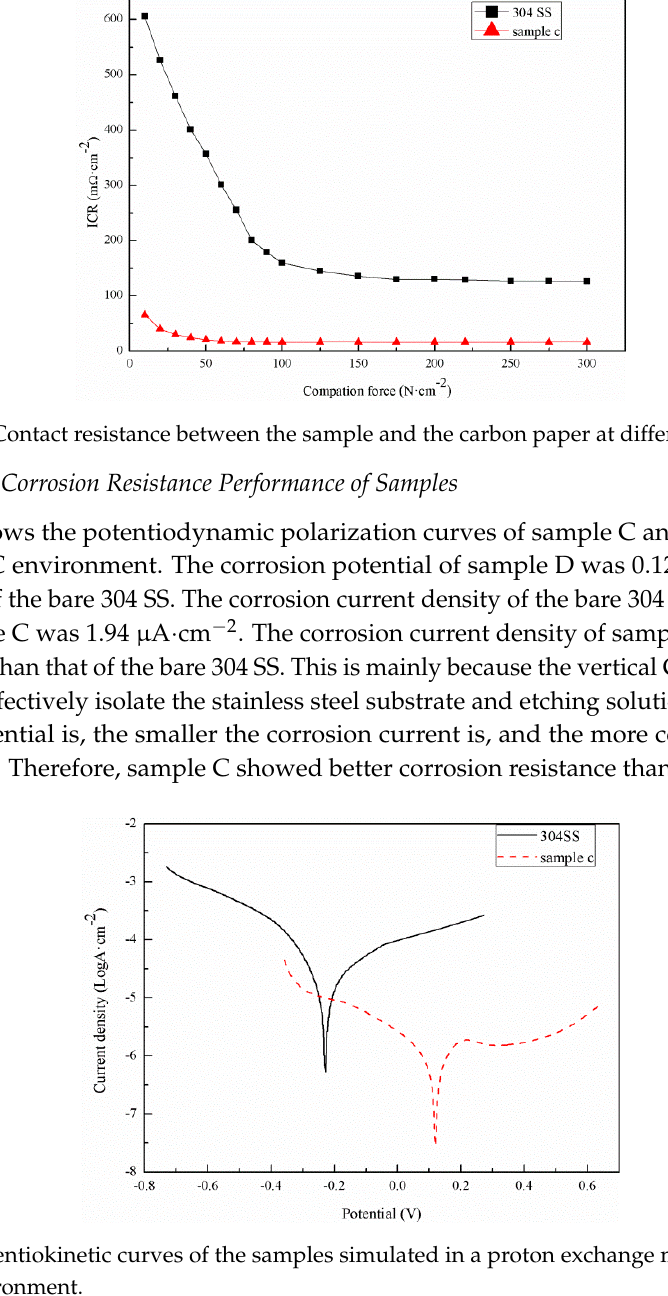
Figure 11. Potentiostatic polarization curves for sample C and the 304 stainless steel in a simulated PEMFC: ( a ) 0.6-V cathodic environment and ( b ) − 0.1-V anodic environment.